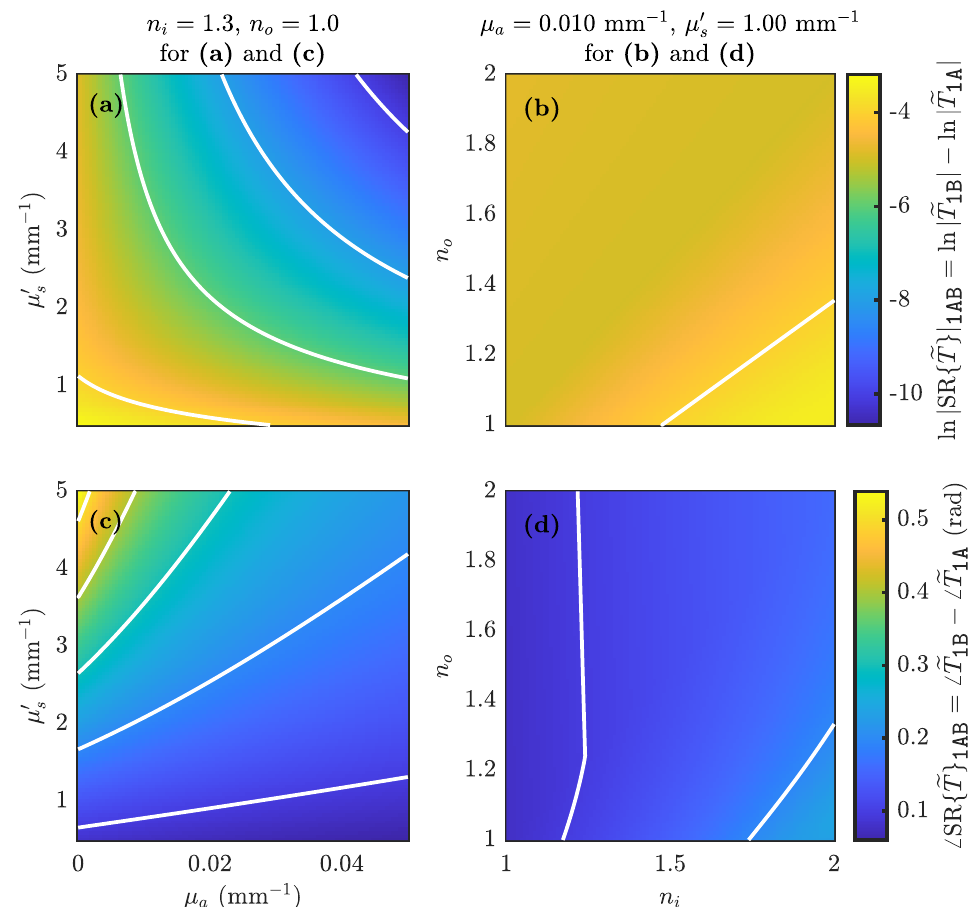
Figure 3. How the measurements of the ln | SR { (cid:101) T }| and ∠ SR { (cid:101) T } (Equations (6) and (5)) are effected by optical parameters, namely the µ a , the µ (cid:48) s , the n inside ( n i ) and the n outside ( n o ). Simulation geometry and parameters not explicitly shown here are stated in detail in Figures 1 and 2. ( a ) ln | SR { (cid:101) T }| versus µ a and µ (cid:48) s . ( b ) ln | SR { (cid:101) T }| versus n i and n o . ( c ) ∠ SR { (cid:101) T } versus µ a and µ (cid:48) s . ( d ) ∠ SR { (cid:101) T } versus n i and n o . Note: ( a , b ) have the same iso-line and color-map values/scales; as do ( c , d ). Acronyms and Symbols: Green’s function for the complex Transmittance ( (cid:101) T ), Single-Ratio of the (cid:101) T (SR { (cid:101) T } ), SR { (cid:101) T } amplitude ( | SR { (cid:101) T }| ), natural logarithm of | SR { (cid:101) T }| (ln | SR { (cid:101) T }| ), SR { (cid:101) T } phase ( ∠ SR { (cid:101) T } ), absorption coefficient ( µ a ), reduced scattering coefficient ( µ (cid:48) s ), and index of refraction ( n ).